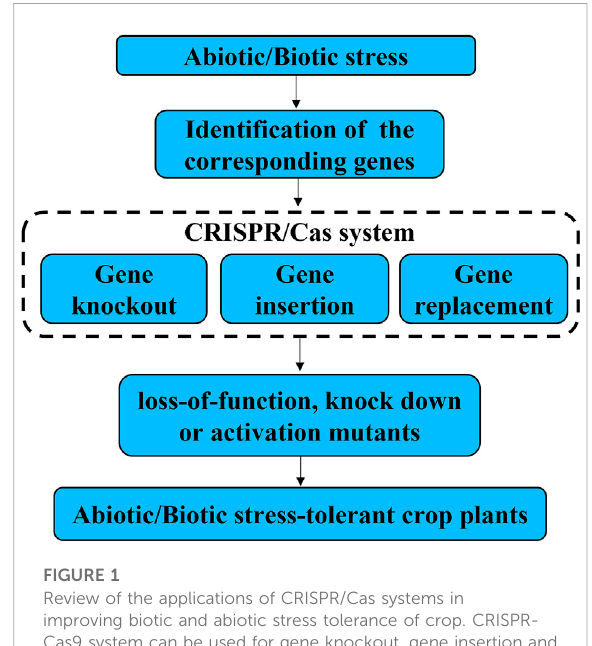
FIGURE 1 Review of the applications of CRISPR/Cas systems in improving biotic and abiotic stress tolerance of crop. CRISPR- Cas9 system can be used for gene knockout, gene insertion and gene replacement, resulting inloss-of-function, knock down or activation mutants, which can lead to generation of abiotic/ biotic stress-tolerant crop